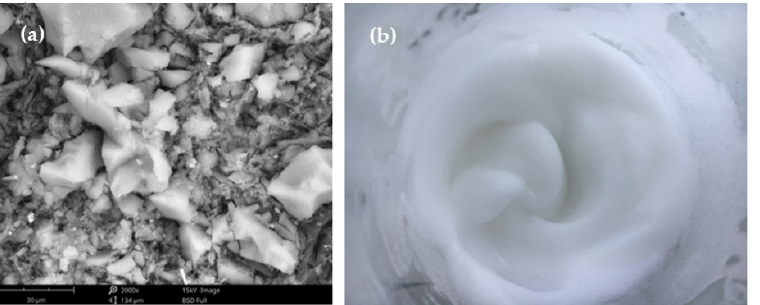
Figure 1. ( a ) SEM image of hydrophobic SiO 2 aerogel in waterborne coating system, ( b ) photo of the